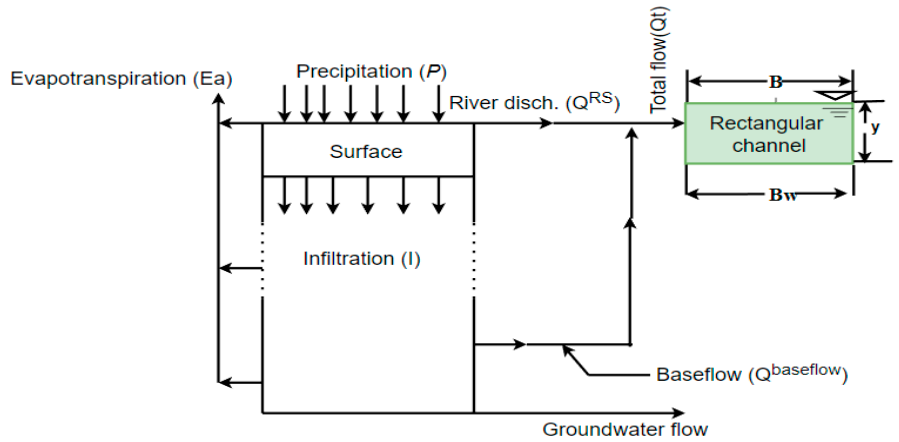
Figure 2. Transportation process of the water cycle [63].